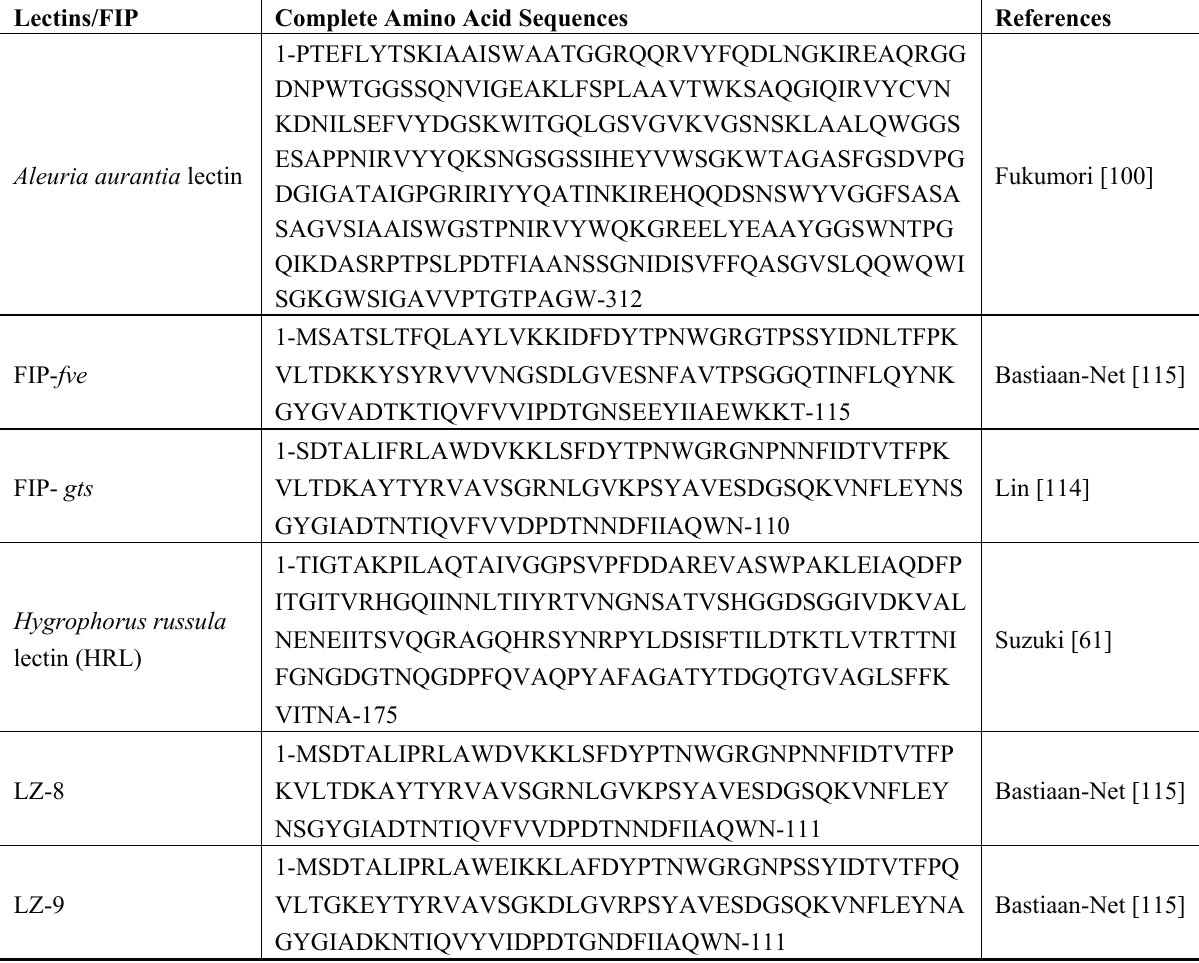
Table 3. Full amino acid sequences of some lectins and related fungal immunomodulatory proteins (FIP) from edible